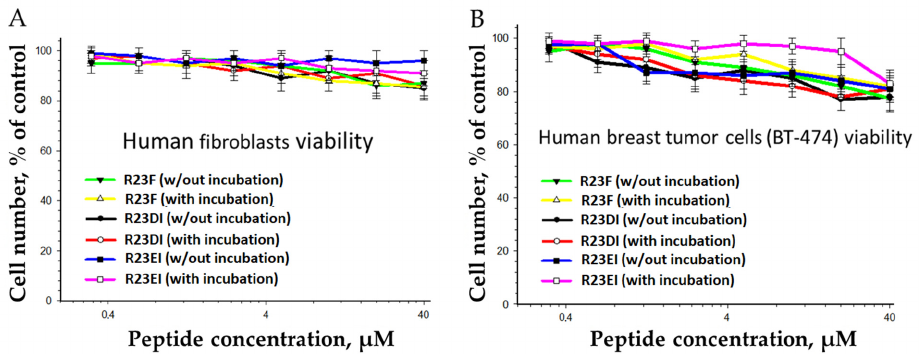
Figure 12. Effect of peptide treatment on the survival of human fibroblasts ( A ) and the breast tumor cell line BT-474 ( B ) without preliminary incubation (18 h, 37 °C, in DMEM with 10% FBS) and after 72 h of co-incubation with peptide. Each of the experiments was carried out at least three times ( n ≥ 3). Error bars show standard deviation